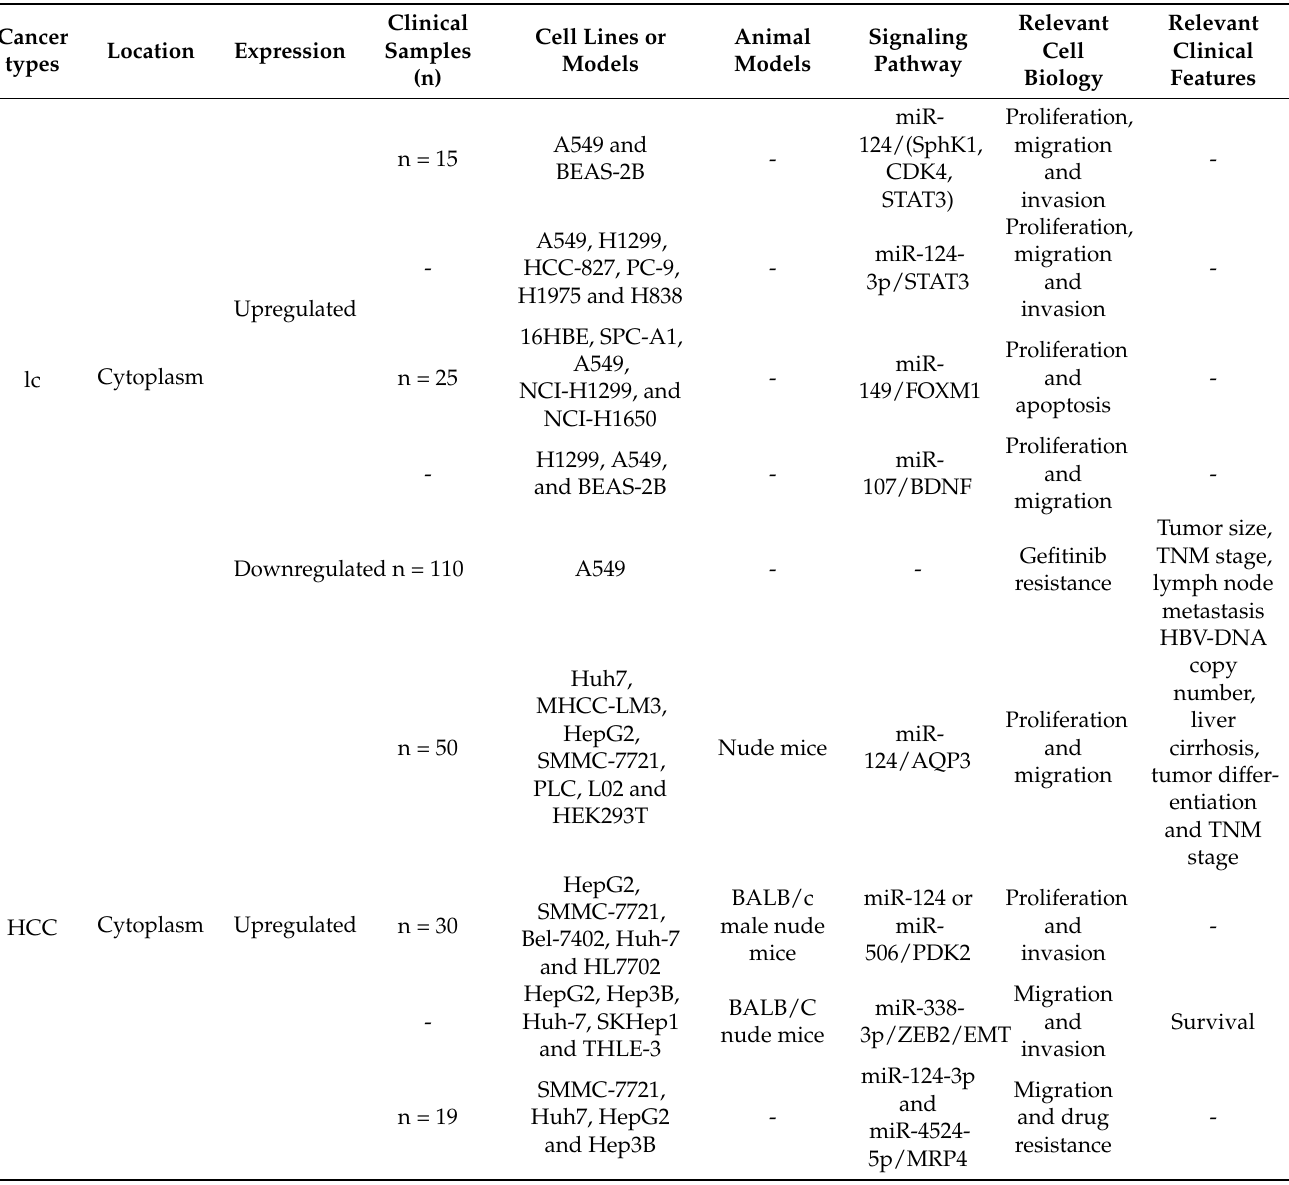
Table 1. The role of circHIPK3 in human